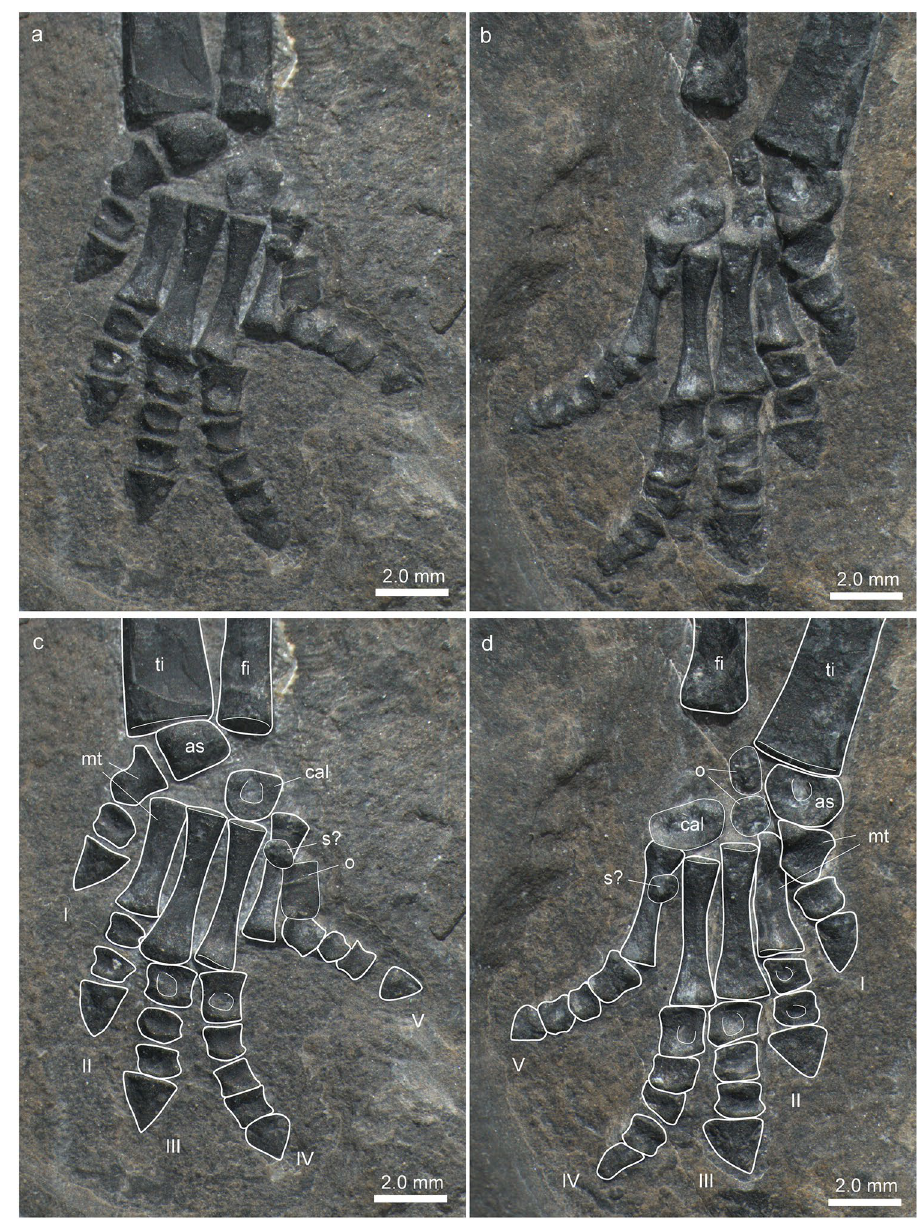
Figure 9. Zeugopodial and autopodial bones of the hindlimb of Eusaurosphargis dalsassoi (PIMUZ A/III 4380). ( a , b ) Photographs. ( c , d ) Photographs overlain by interpretative drawings. Abbreviations used in the figure are astragalus (as), calcaneum (cal), fibula (fi), osteoderm (o), sesamoid (s), tibia (ti), and digits 1 to 5